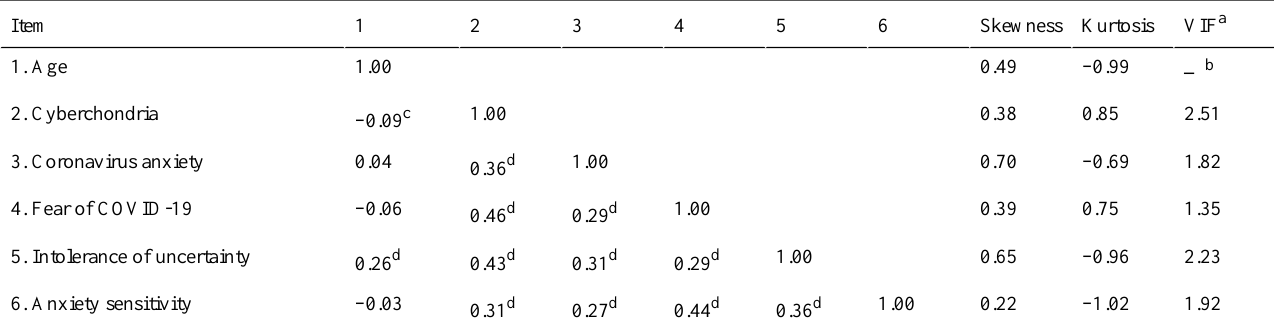
Table 2. Correlation matrix of main variables